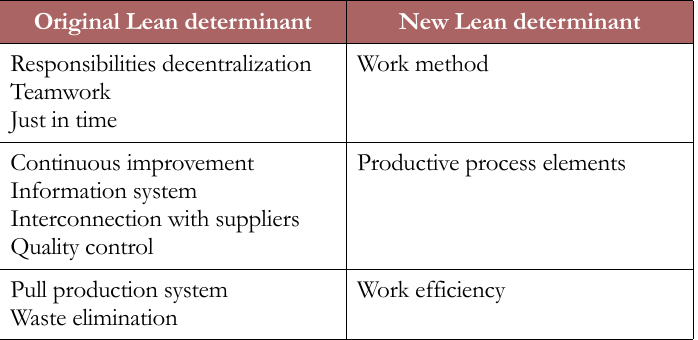
Table 7. New Lean determinants